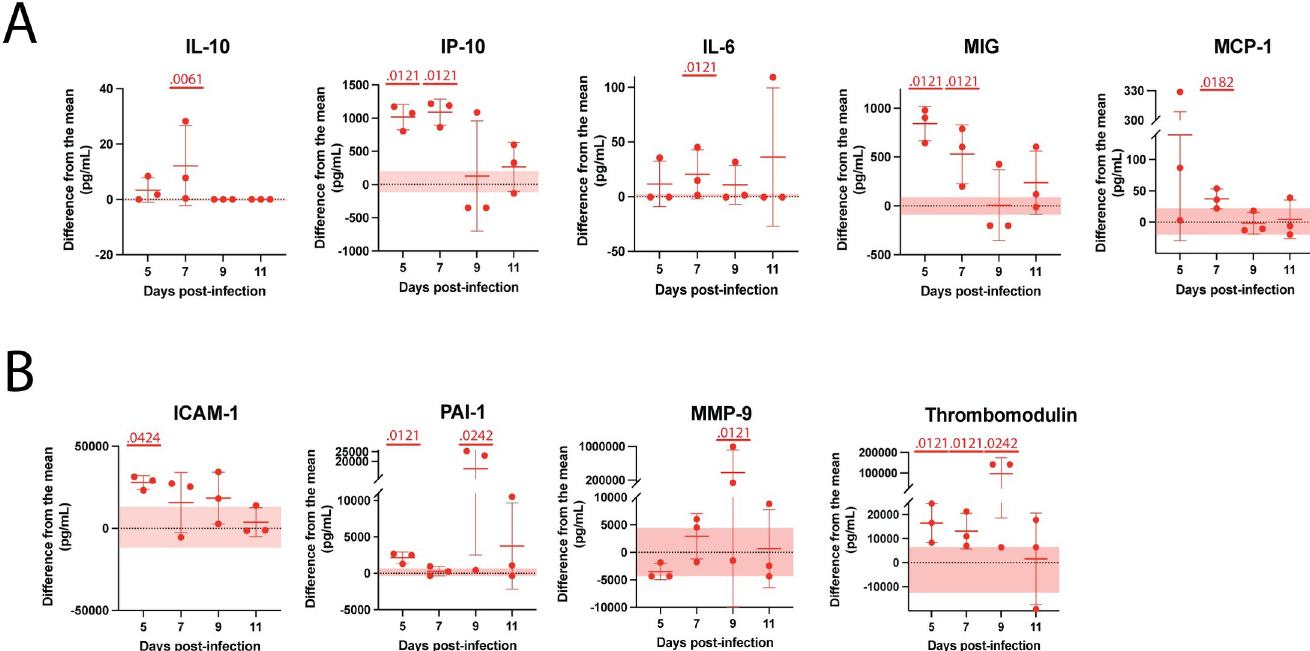
Fig 7. Cytokine signaling and markers of endothelial activation in RVFV-infected CC057 mice. Analyte concentrations in the plasma over time with data presented as a function of difference from the uninfected mean, shown as mean ± SD (n = 3 mice/time point). Each data point shown represents an individual mouse. Pink horizontal shading represents uninfected normal ranges from the mean for CC057 mice. For each analyte, comparisons were performed at each timepoint by Mann-Whitney to compare RVFV-infected samples to uninfected control samples. A) Cytokines and chemokines: IL-10 (7 dpi p = 0.0061); IP-10 (5 dpi p = 0.0121; 7 dpi p = 0.0121); IL-6 (7 dpi p = 0.0121); MIG (5 dpi p = 0.0121; 7 dpi p = 0.0121); MCP-1 (7 dpi p = 0.0182). B) Tissue barriers: ICAM (5 dpi p = 0.0424); PAI-1 (5 dpi p = 0.0121; 9 dpi p = 0.0242); MMP-9 9 dpi (p = 0.0121); Thrombomodulin (5 dpi p = 0.0121; 7 dpi p = 0.0121; 9 dpi p = 0.0242).